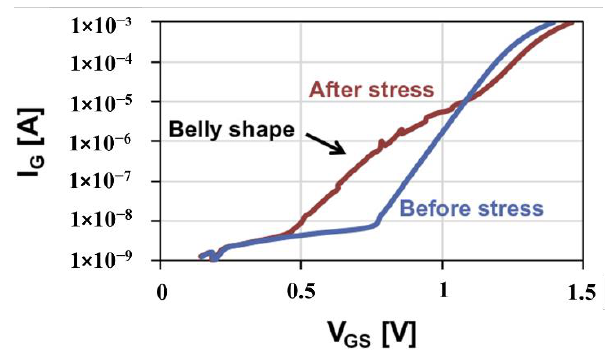
Figure 39. Before ( blue ) and after ( red ) 4000 h of HTRB stress, the forward characteristics of an HEMT with BS are shown. Reproduced with permission [168]. Copyright 2013, Elsevier.